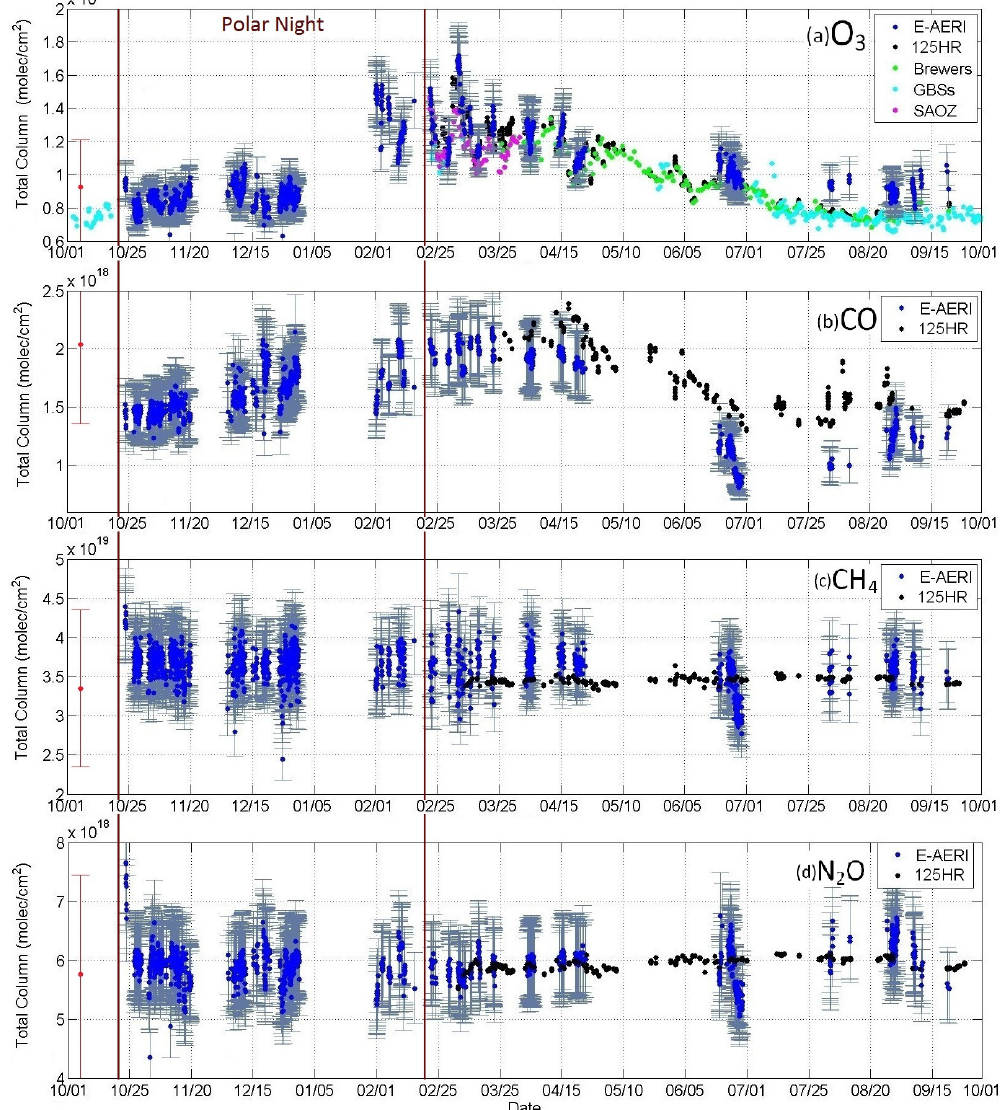
Fig. 3. Total column measurements of (a) O 3 , (b) CO, (c) CH 4 , and (d) N 2 O from the PEARL Ridge Lab. Dates are given as MM/DD from 2008 to 2009. E-AERI (blue), 125HR (black), three Brewers (green), two GBSs (cyan), and the SAOZ (pink) measurements are shown for comparison. Error bars are shown only for the E-AERI for clarity. The a priori column is shown for one day (red) with error bars corresponding to the diagonal of S a . Polar night is indicated between the brown vertical